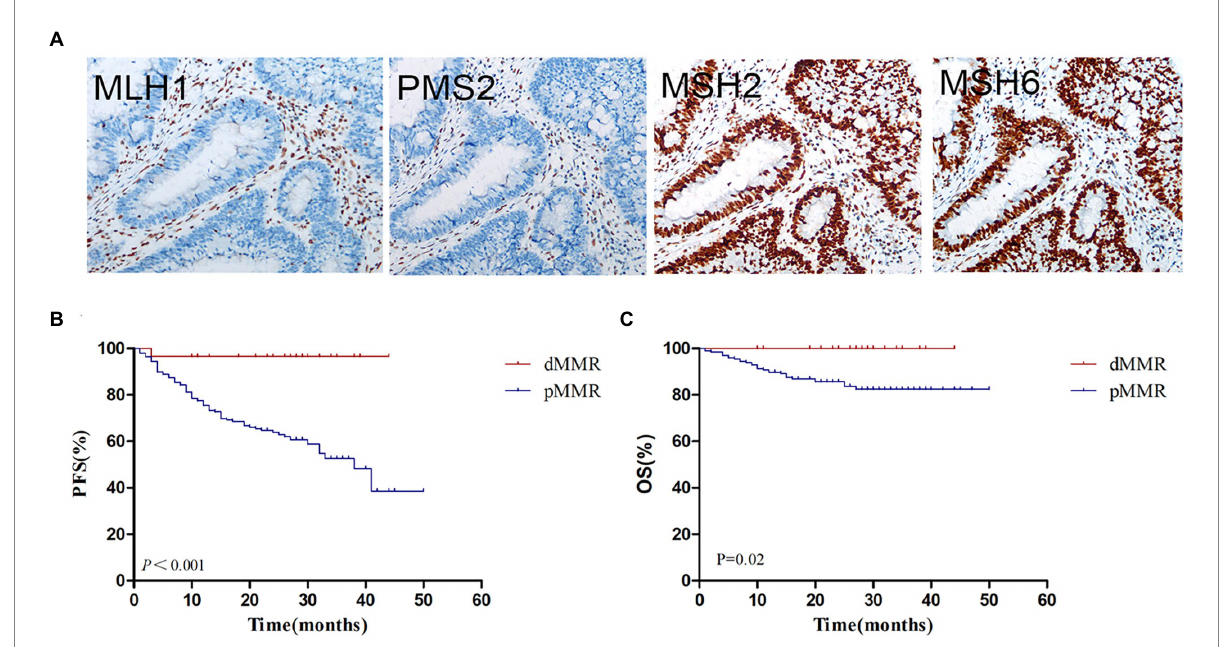
FIGURE 2 MMR status assessment and its relationship with survival. (A) Immunohistochemistry for MMR proteins of MLH1, PMS2, MSH2 and MSH6. (B) Kaplan–Meier plot of progression-free survival in CRC patients with dMMR and pMMR status. (C) Kaplan–Meier plot of overall survival in CRC patients with dMMR and pMMR status. dMMR, deficient DNA mismatch repair; pMMR, proficient DNA mismatch repair.